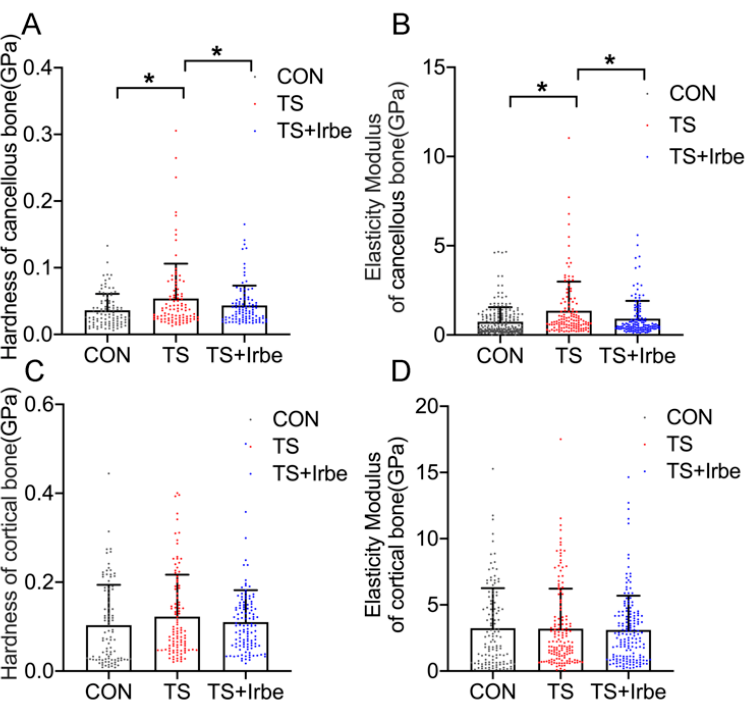
Figure 4. Inhibition of AGEs improved bone micromechanical properties after tail suspension. ( A ) Hardness of cancellous bone. ( B ) Elasticity modulus of cancellous bone. ( C ) Hardness of cortical bone. ( D ) Elasticity modulus of cortical bone. Values are all expressed as mean ± SD. * p < 0.05.